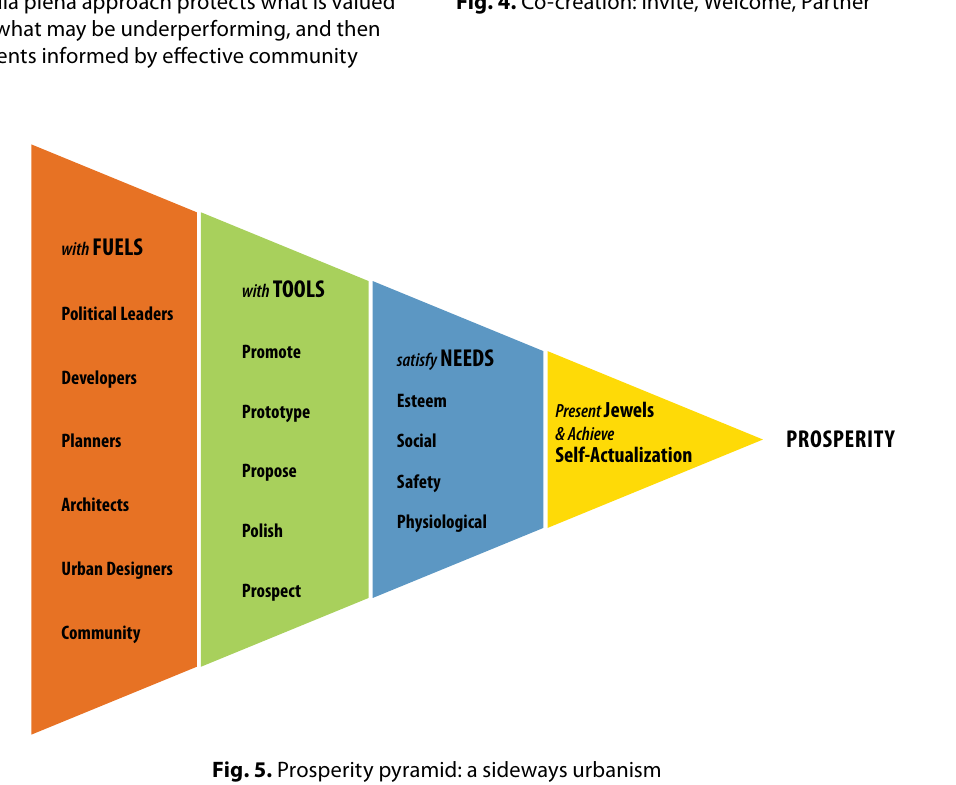
Fig. 4. Co-creation: Invite, Welcome, Partner